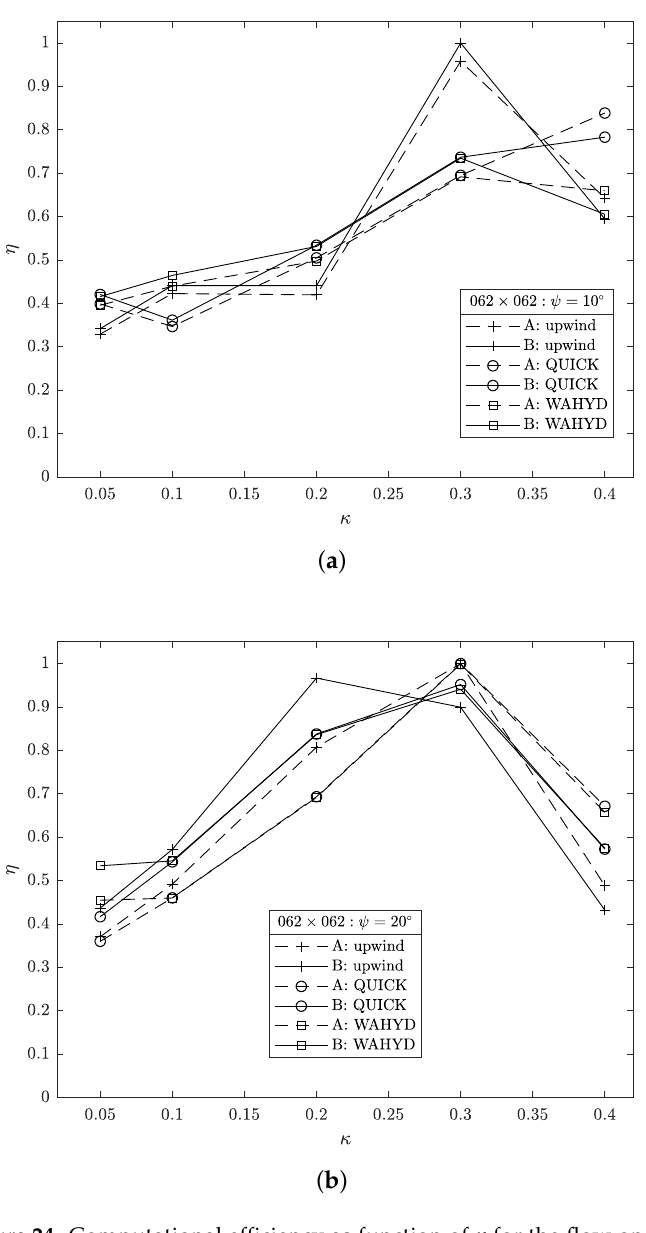
Figure 24. Computational efficiency as function of κ for the flow on a skewed-channel case using grid 62 × 62 and ψ : ( a ) 10º, ( b )